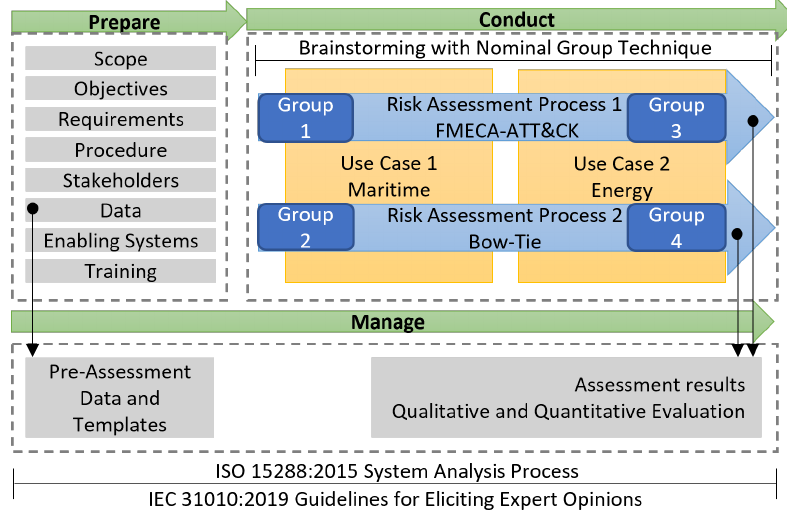
Figure 4. Evaluation methodology.